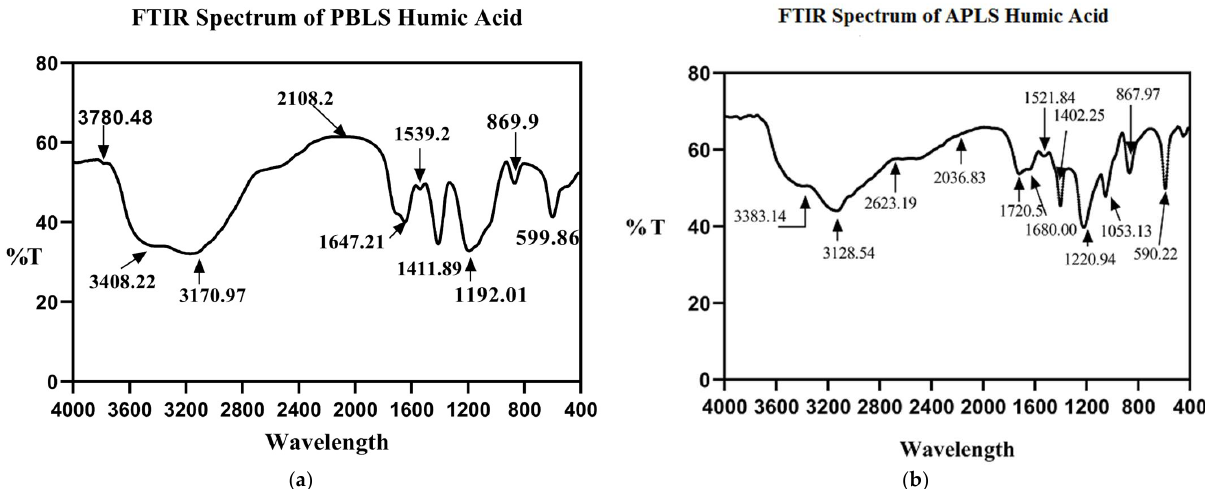
Figure 6. FTIR spectrum analyses of ( a ) PBSL humic acid and ( b ) APSL humic acid. FTIR outcomes indicate the significant presence of aromatic compounds, carboxylic, and amide groups in the extracted humic acid. Broader peaks appearing at 2108.2 cm −1 (PBLS) and 2036.83 cm −1 (APLS) correspond to alkynes (C-C stretching), the C-O group (strong), and =C- H group (strong), while another peak at 1647 cm −1 and 1680 cm −1 repre- sents the structural vibration of aromatic double bonds C=C [28]. A sharp peak at 1411 cm −1 and 1402.25 cm −1 is linked with the distortions of the carboxylic group or COO− ir- regular stretching, the existence of aromatic groups (C-C stretch, intense), and saturated hydrocarbons (C-H-C bend) [12]. Besides these, peaks also appear at 3170 cm −1 and 3128.54 cm −1 , which indicate the presence of C-H stretching in the carboxylic acid group (-COOH) along with H-bonded OH groups as well as 1°, 2° amines with trace N-H stretching [21]. Declining tendencies were detected for the peaks at 1647 cm −1 , 1680 cm −1 and 1411 cm −1 , and 1402.25 cm −1 in isolated humic acid (Table 1). Table 1. Overview of FTIR outcomes for isolated humic acid. Objects